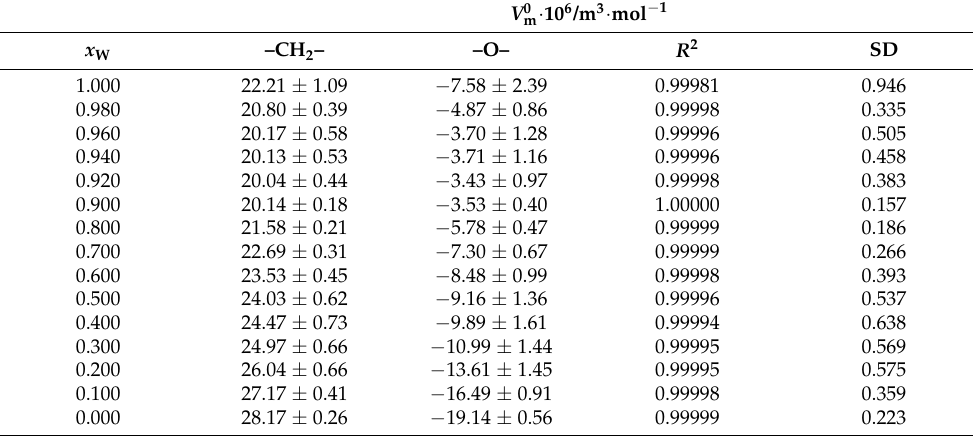
Table 10. The average effect of the interaction between the –CH 2 – or –O– group and molecules of the DMF + W mixed solvent in V 0 m at 298.15 K.